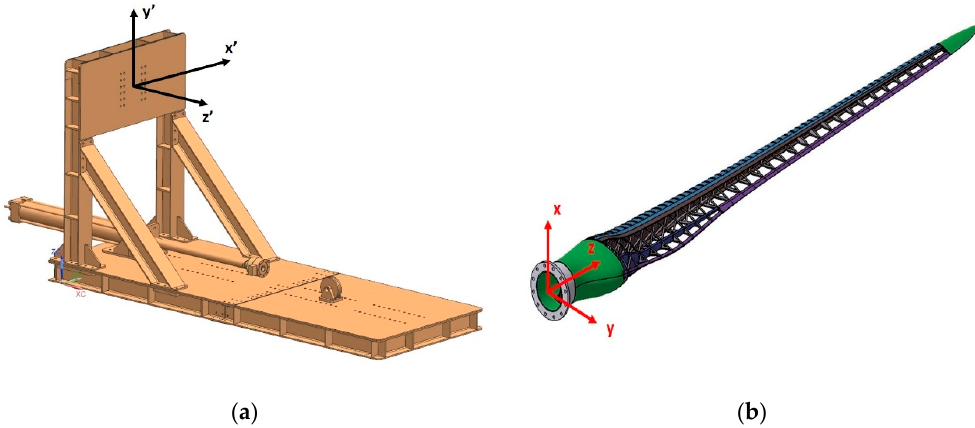
Figure 16. The coordinate system: ( a ) the global coordinate system and ( b ) the blade coordinate system.